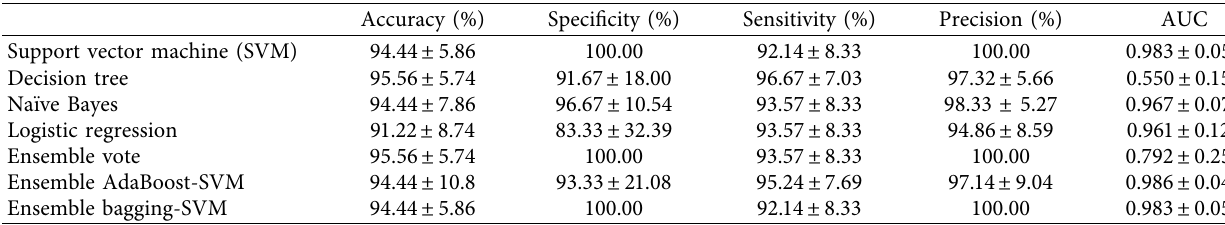
Table 3: Performance of classification models by